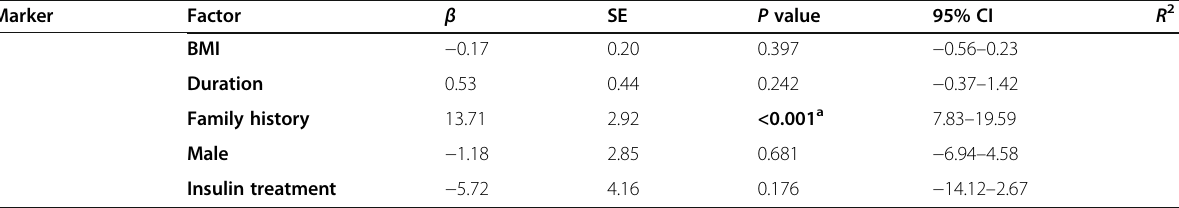
Table 4 Linear regression for factors affecting methylation in the T2D patients (Continued) Marker